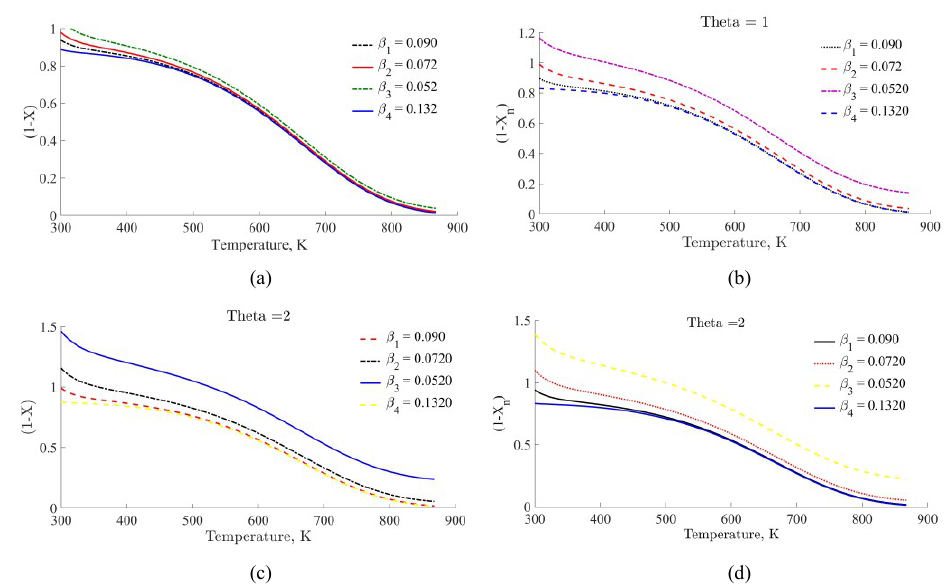
Fig. 4. The effect of shape parameter ( β ) of the Weibull distribution on the numerical results of bi-variant scheme for DAEM: (a) first order reaction ( θ = 1); (b) n th order reaction ( θ = 1); (c) first order reaction ( θ = 2); (d) n th order reaction